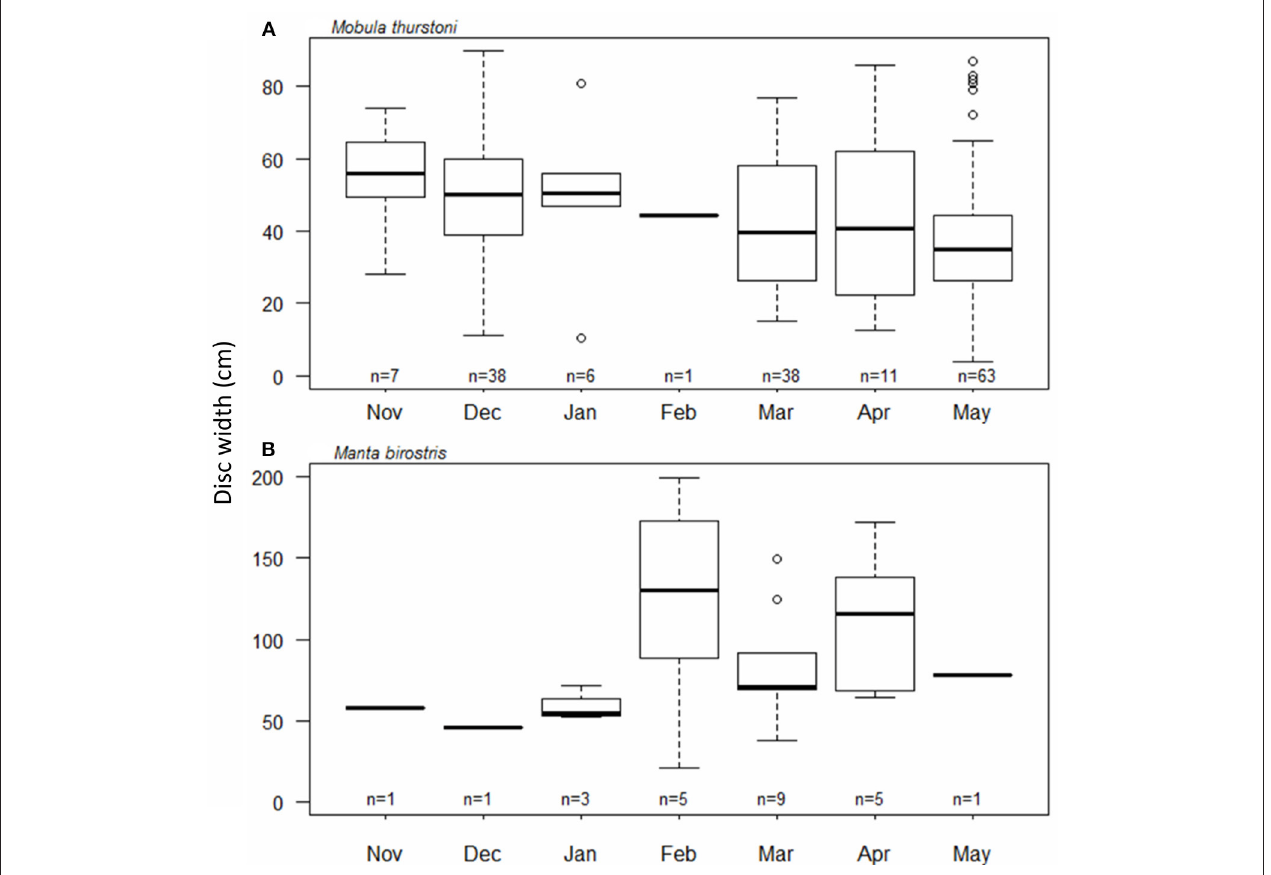
FIGURE 5 | Fetus size distribution throughout the months for (A) M. thurstoni , and (B) M. birostris . For each distribution, horizontal lines from bottom to top: lower value, first quartile, median, third quartile, and upper value. Circles represent suspected